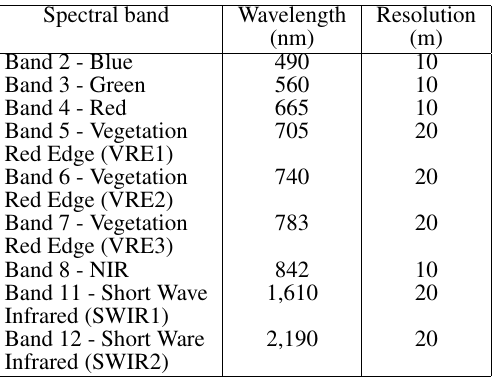
Table 1. Sentinel-2 multispectral bands used in this study.